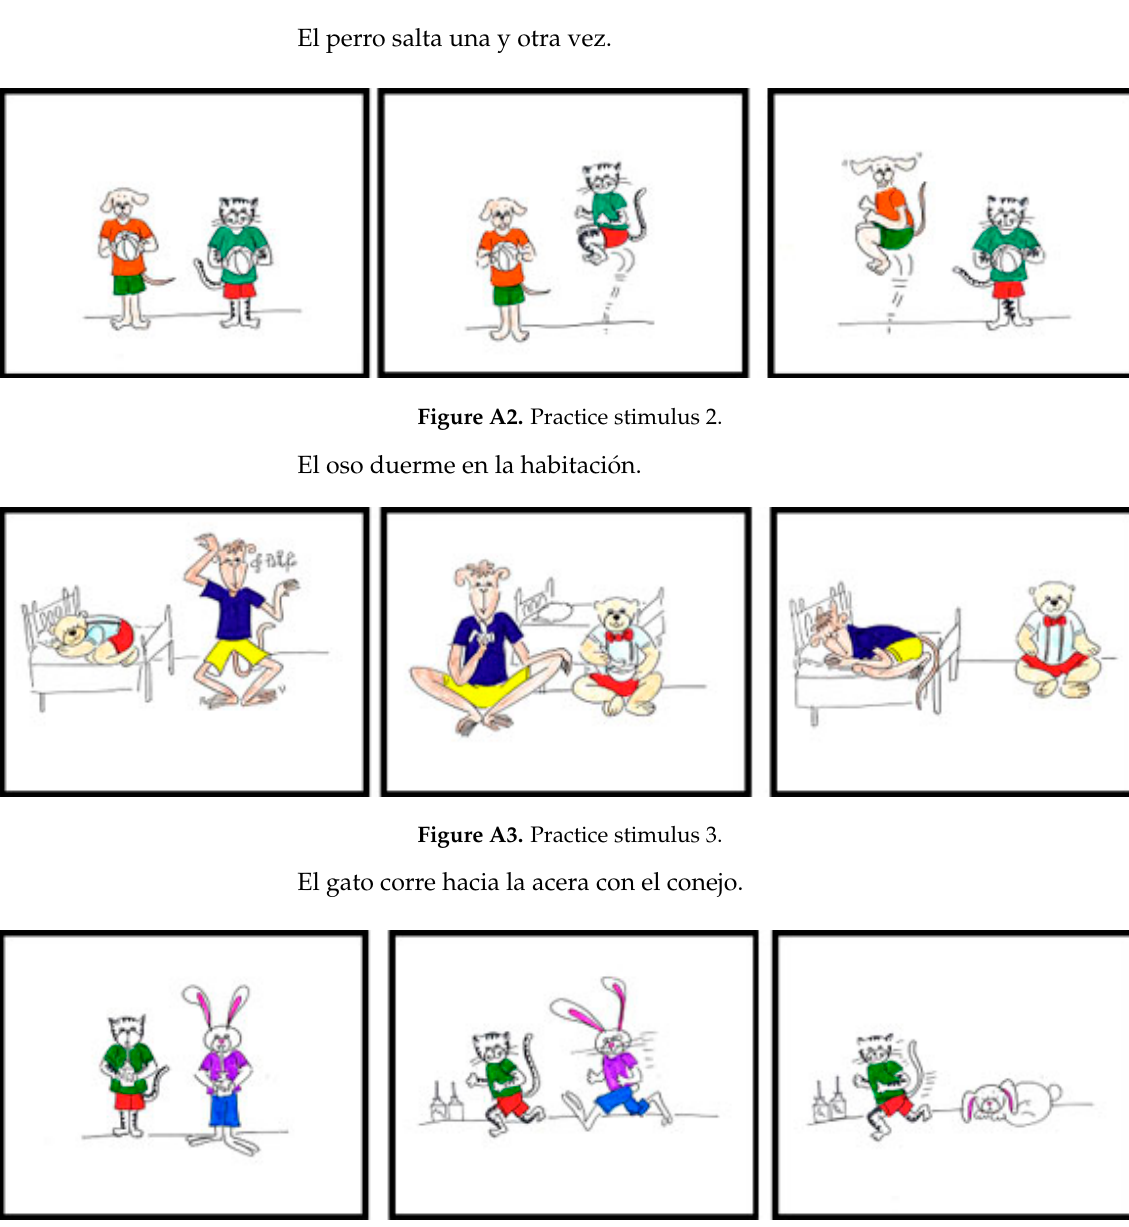
Figure A4. Practice stimulus 4. Después de patear al gato, el perro salta.